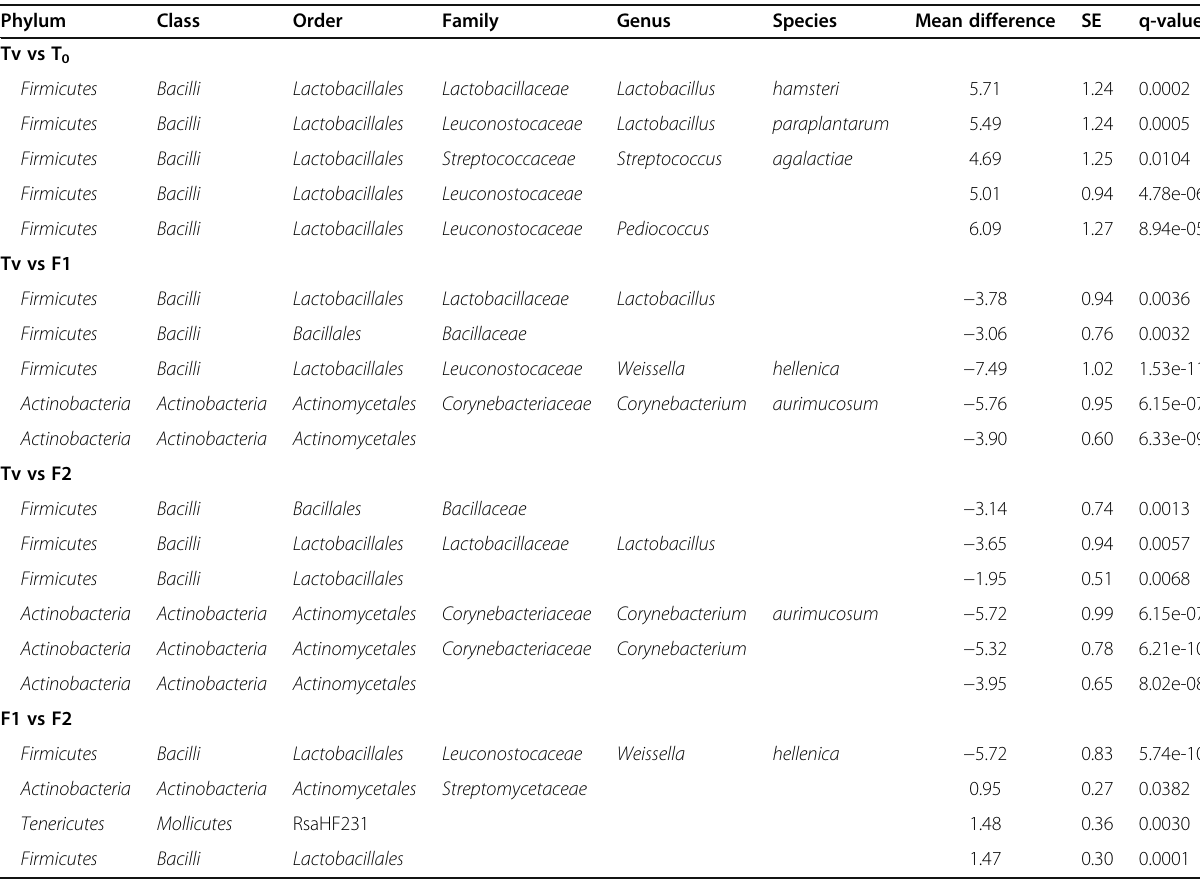
Table 1 Mean differences of taxa absolute abundance between groups (natural log scale) and standard errors (SEs). The analysis is based on the “ Analysis of Compositions of Microbiomes with Bias Correction ” (ANCOM-BC). Only taxa with significantly different abundance between diets are shown (adjusted p -value < 0.05, Bonferroni correction)